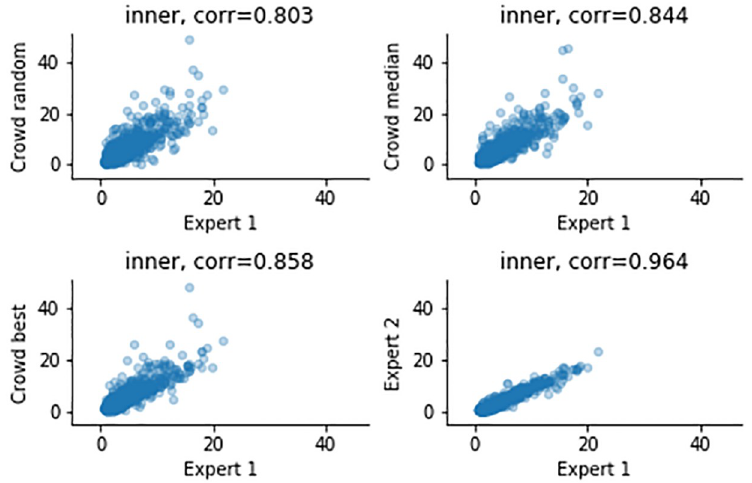
Fig 5. Measurements of the inner airway, comparing expert 1 (x-axis) and to three combining methods and expert 2 (y-axis).